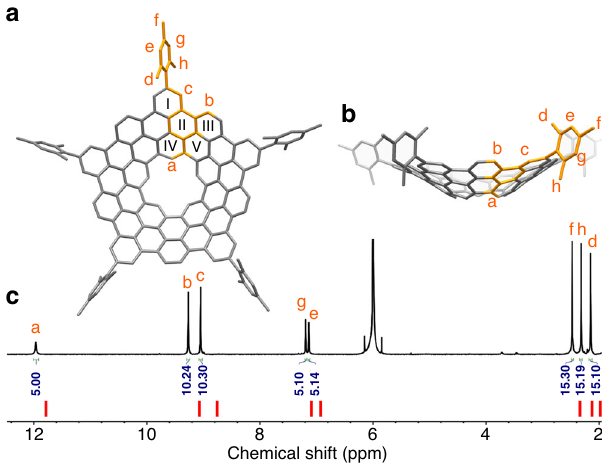
Fig. 3 NMR characterization of 1. a Top view of DFT-optimized 1 . The asymmetric unit is highlighted in orange. b . Side view of DFT-optimized 1 . All hydrogens in the asymmetric unit are labeled from a to h. The hexagonal rings of 1 are labeled by Roman numerals. c . 1 H-NMR spectrum of 1 measured in C 2 Cl 4 D 2 . The theoretical NMR spectrum of 1 is represented by the short vertical red lines below. Signal assignment is aided by 2D NMR spectroscopy (see Supplementary Note 1, Supplementary Figures 24 –